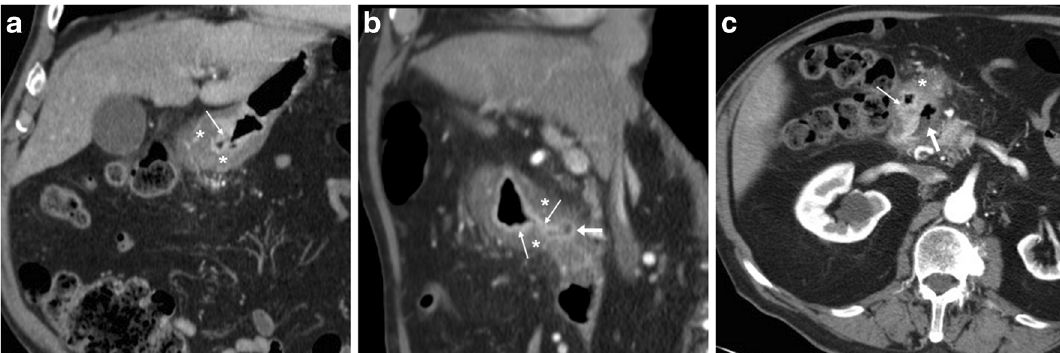
(*), mucosal hyperenhancement best seen in arterial-phase images (thin arrows), and a posterior prepyloric deep ulcer crater (arrows) filled by fluid and air, which was subsequently confirmed by